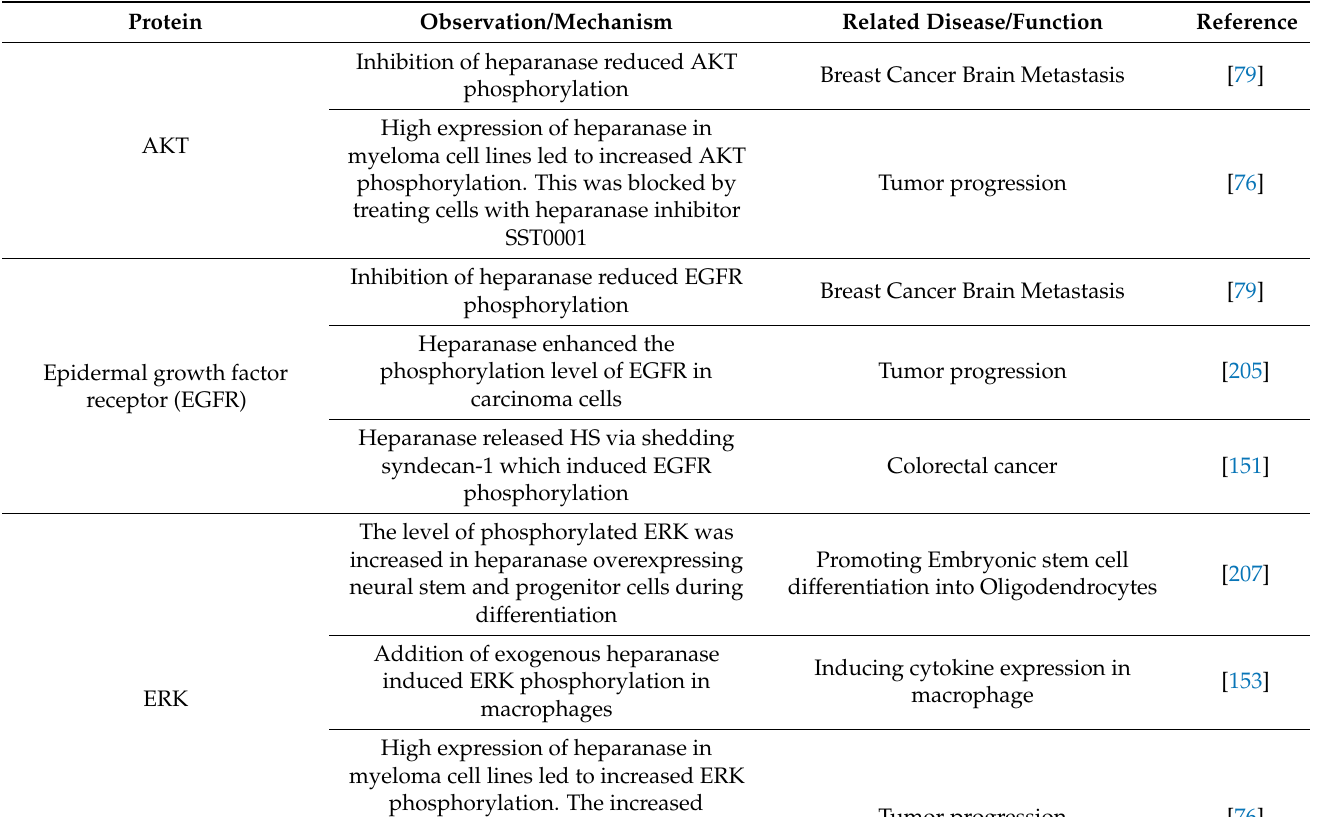
Table 4. Heparanase regulates protein